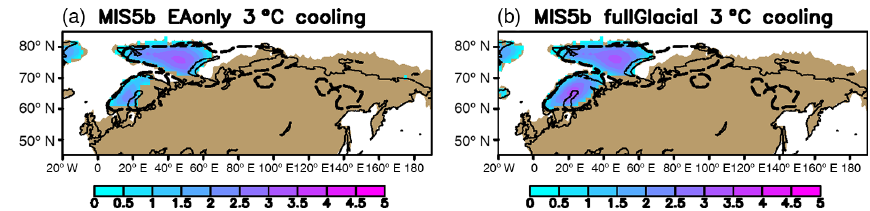
Figure 10. Simulated equilibrium ice thickness in Eurasia (shading; in km) using the MIS5b (with PI OHT) climate forcing from the EAonly (a) and fullGlacial (b) simulations in addition to an imposed 3 ◦ C cooling of the JJA surface temperature across the entire